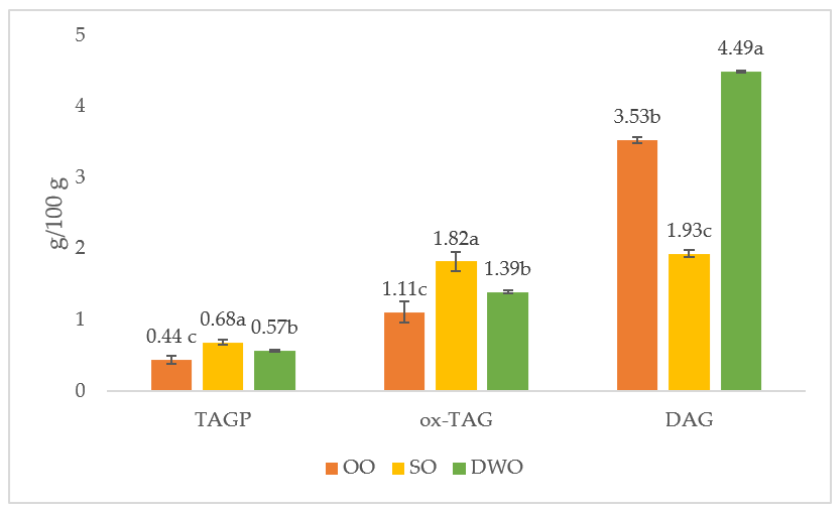
Figure 2. Polar compounds content (g/100 g of extracted fat) of focaccia. SO = focaccia with sunflower oil; OO = focaccia with olive oil; DWO = focaccia with durum wheat oil; TAGP = triacylglycerol oligopolymers; ox-TAG = oxidized triacylglycerols; DAG = diacylglycerols. Data are presented as means ± SD of three replicates. Different letters in the same row indicate significant differences at p < 0.05.